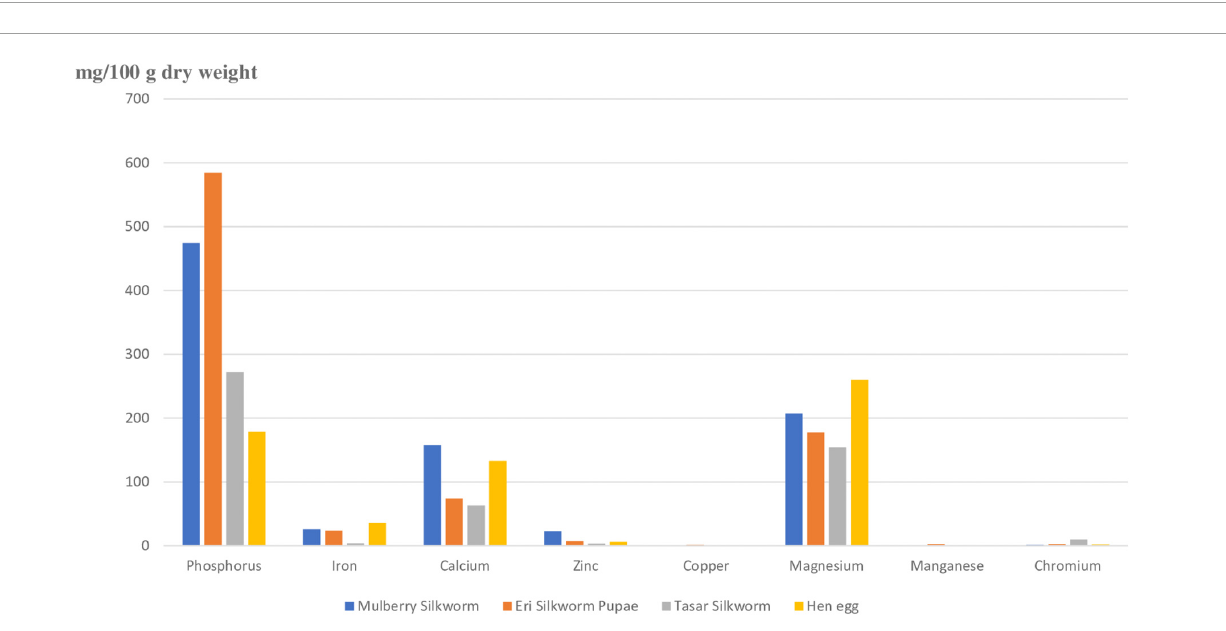
FIGURE4 Depicting amount of minerals present in pupae of different types of silkworms against minerals present in egg. Phosphorus, magnesium, and calcium are the major minerals present in silkworms. Silkworm pupae have more minerals as compared to hen egg. Phosphorus is highest in eri silkworm, Calcium, and Zinc is highest in mulberry silkworm and chromium in tasar silkworm. The amount of iron is very less in tasar silkworm. Manganese is present very less amount in all the silkworms and almost absent in tasar silkworm, Among all the minerals present in silkworms phosphorus is present in highest amount. The amount of chromium is present least in eri